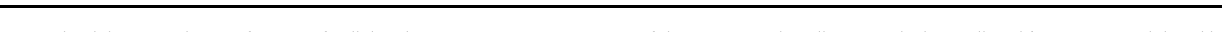
Fig. 8 Growth inhibition and quanti fi cation of cellular characteristics. a Evagination of the optic vesicle still occurred when cell proliferation was inhibited by aphidicolin (see also Supplementary Fig. 13). Scale bar: 100 μ m. b Regions analyzed for the quanti fi cation of cellular characteristics (speci fi cally, cell area c , cell shape d , and division orientation f ). Scale bars: 100 μ m ( upper left in b ), 10 μ m ( upper right in b ). c Mean cell size differed slightly depending on